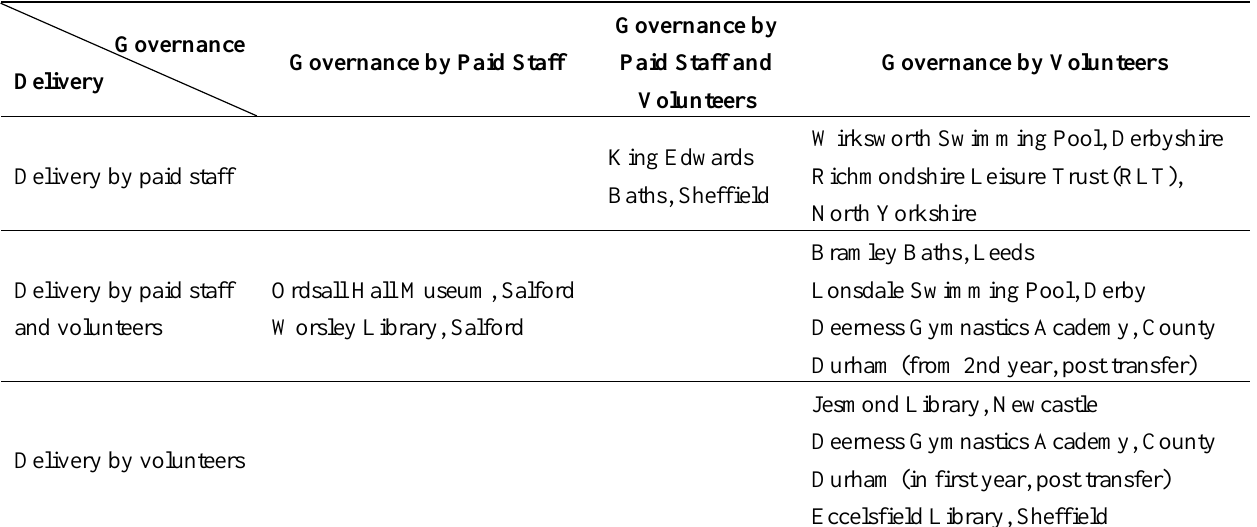
Table 1. Examples of Delivery and Governance of Leisure Services Post Asset